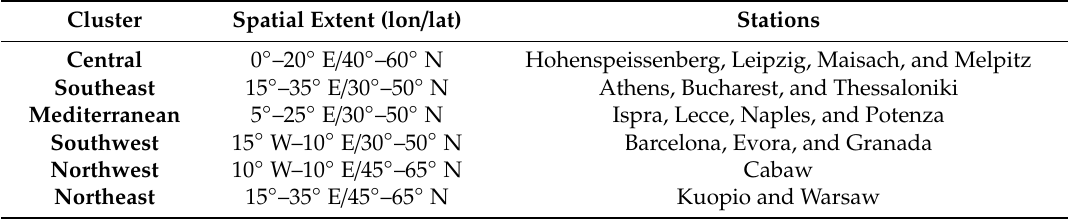
Table 3. The clusters of European Aerosol Research Lidar Network (EARLINET) and Aerosol Robotic Network (AERONET) stations and their spatial extent.